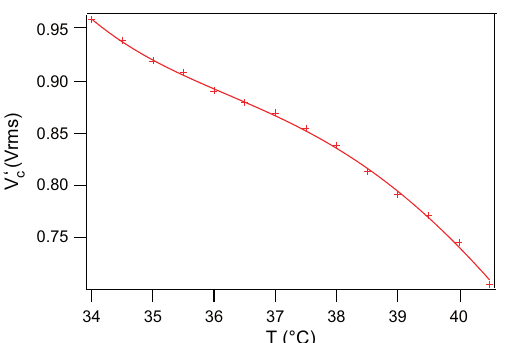
Figure 6. Critical Fréedericksz voltage as a function of temperature measured in a planar sample of thickness d = 50 µ m. The solid line is just a guide for the